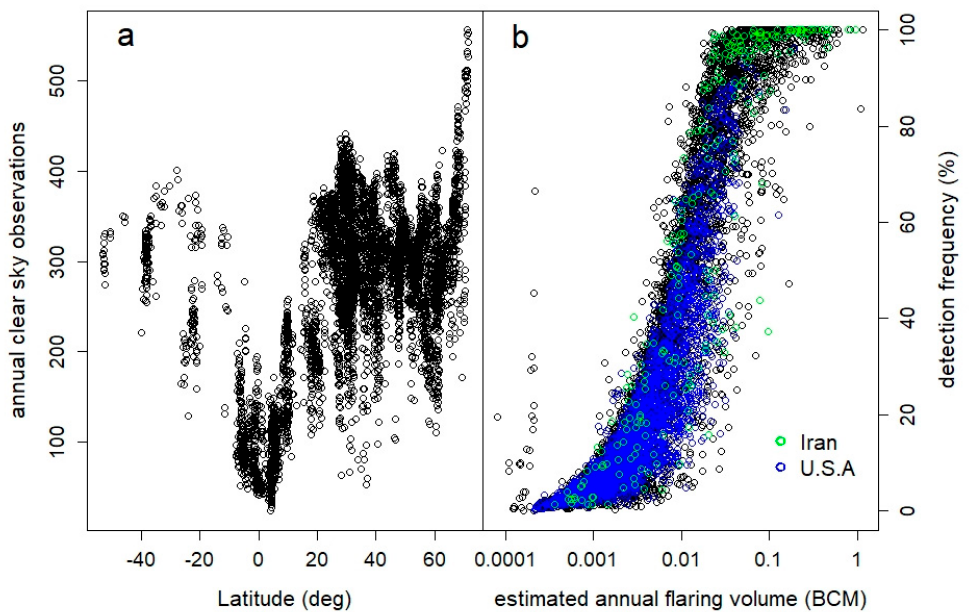
Figure 1. ( a ) Available clear-sky flare observations by VIIRS in 2019 versus latitude; ( b ) 2019 detection frequency (ratio of observations of a flare detected under cloud-free conditions to total observations for that location under cloud-free conditions) as a function of estimated flaring volume (BCM = billion cubic meters, per year), demonstrating that large flares operate nearly continuously, while small flares tend to be intermittent.